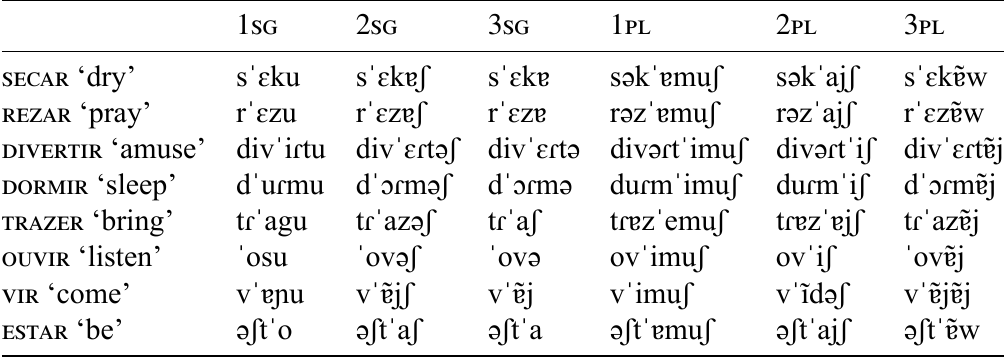
Table 3: Present indicative of verbs with deviant